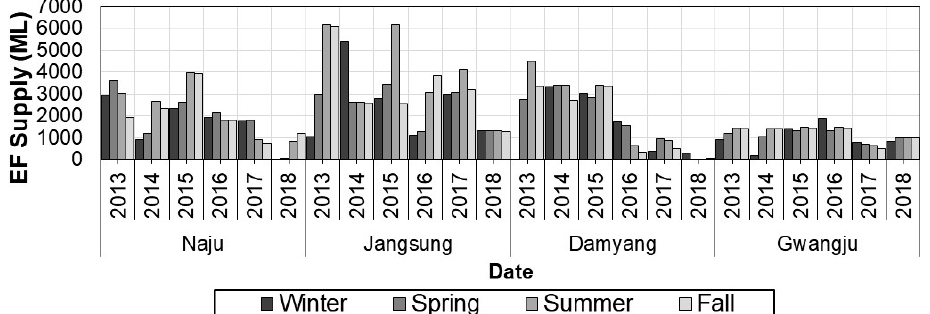
Figure 4. Seasonal variation of historical EF supply from the four reservoirs.